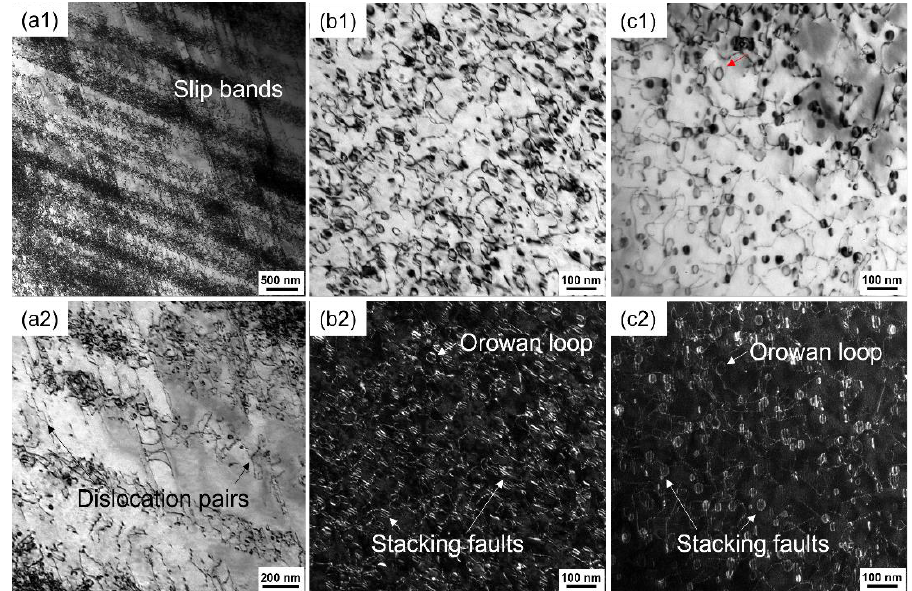
Figure 8. TEM bright-field images of ( a1 ) low magnification and ( a2 ) high magnification of dislocation configurations after tensile deformation at room temperature, ( b1 , c1 ) dislocation configurations after tensile deformation at 700 °C and 750 °C, respectively. ( b2 , c2 ) Corresponding TEM dark-field images.